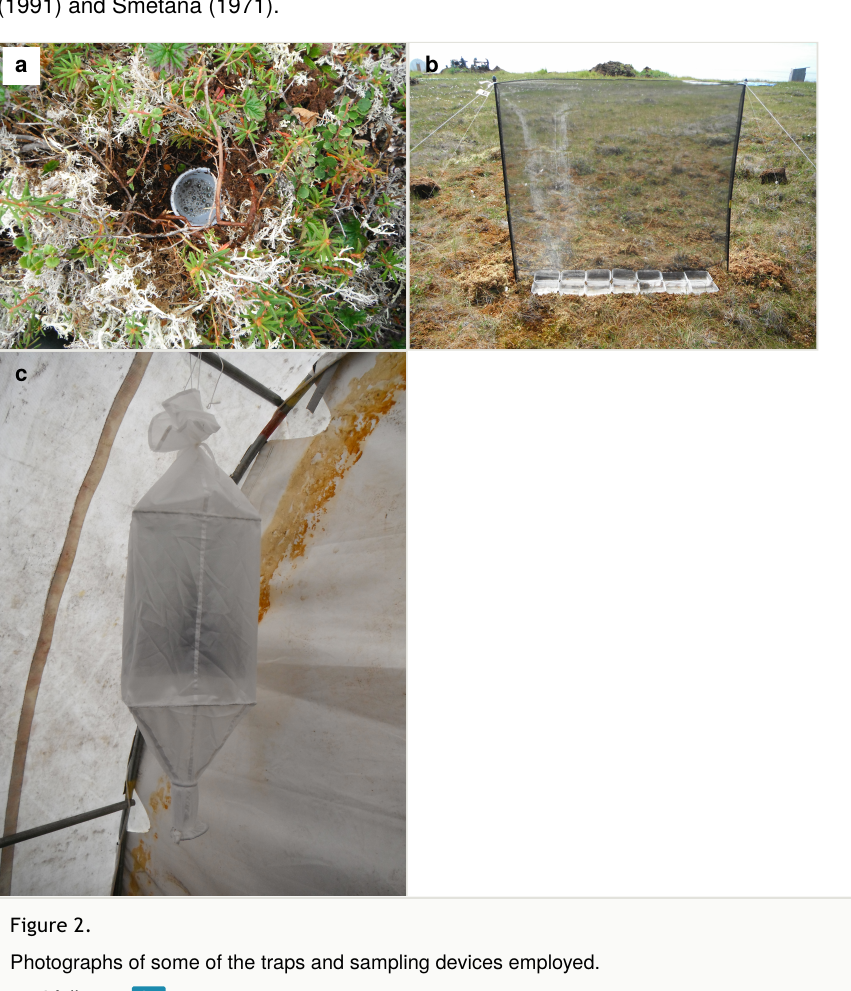
Photographs of some of the traps and sampling devices